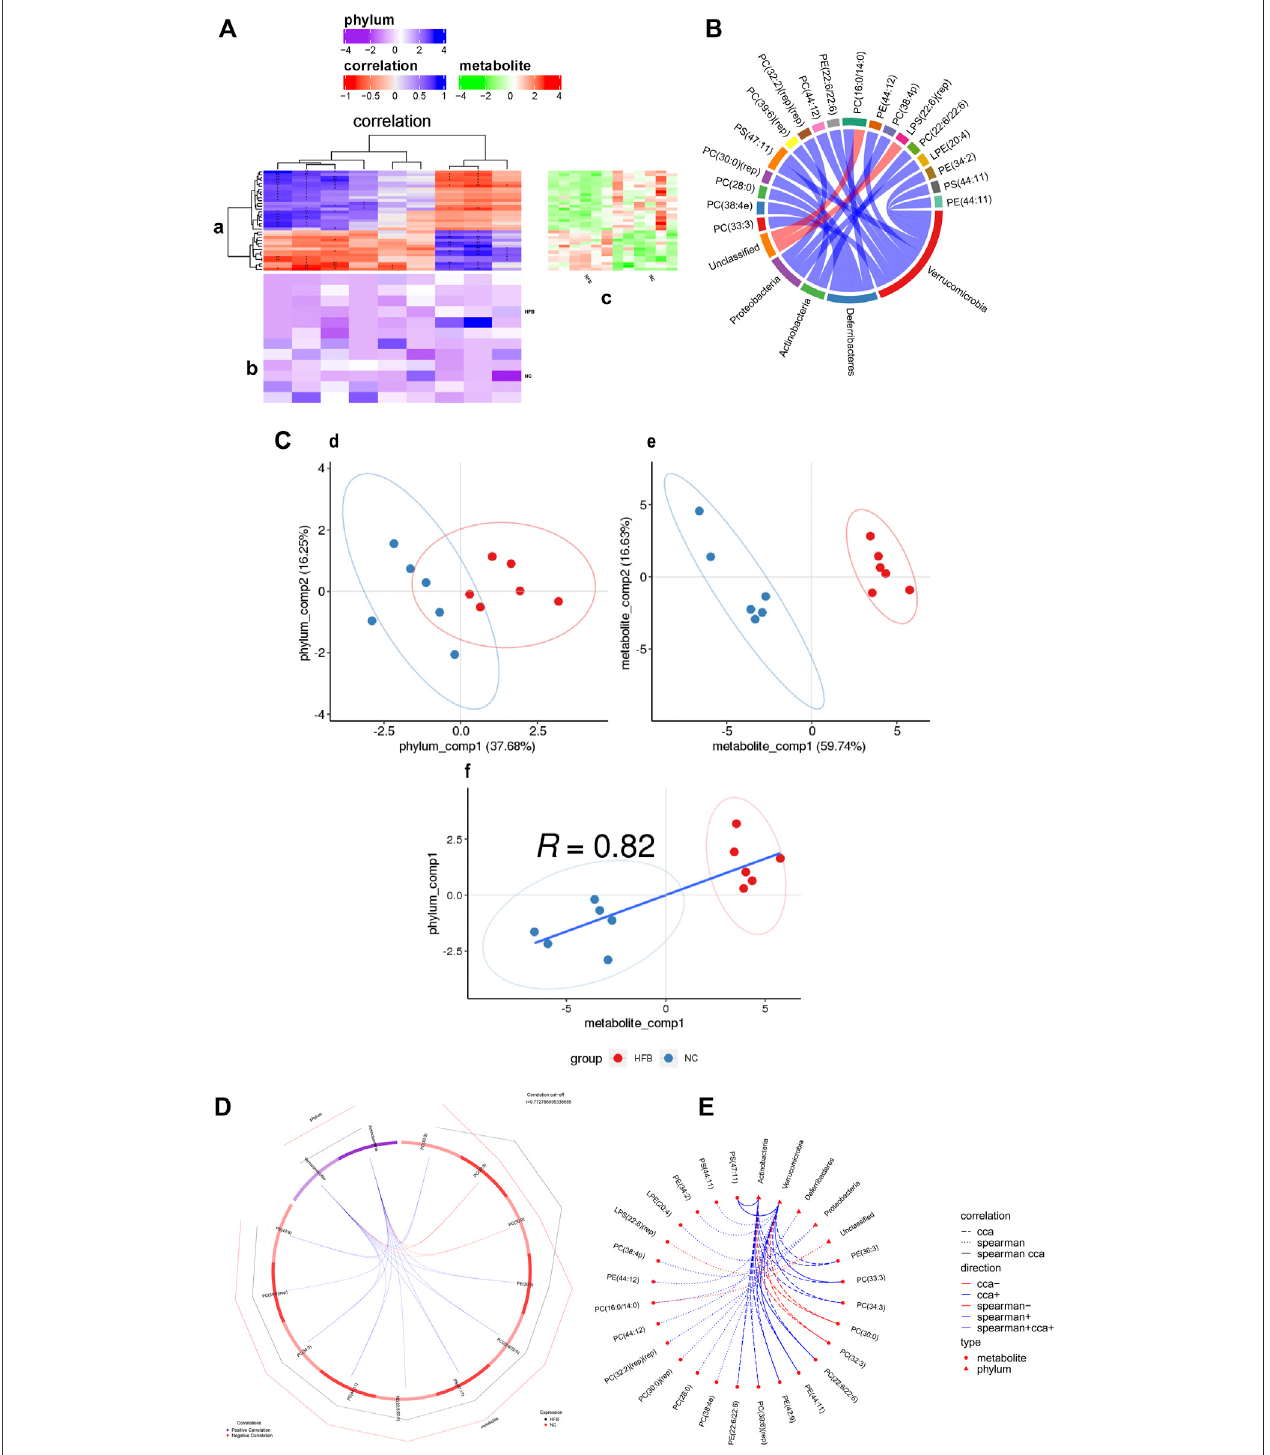
FIGURE6| Correlation analysisofdifferentialmetabolites andmicrobialtaxa intheprefrontalcortex tissue ofApoE − / − mice fedcontinuous high-fat dietscombined with bound stimulation. (A) Heat map of the correlation between differential metabolites and microbial taxa in prefrontal cortex tissue. (a) clustering heat map of correlation between differential metabolites and microbial taxa, horizontal coordinates are microbial taxa, vertical coordinates are differential metabolites, * indicates p value < 0.05,** indicates p value < 0.01;red indicatesanegative correlation,blueindicatespositivecorrelation,thedarkerthecolor,thestrongerthecorrelation; (b) heatmapofrelativeabundanceofmicrobialtaxa,rowsrepresentsamples,rownamesaregroupnames,columnsrepresentmicrobialtaxa,thosewithcolumnnamesare